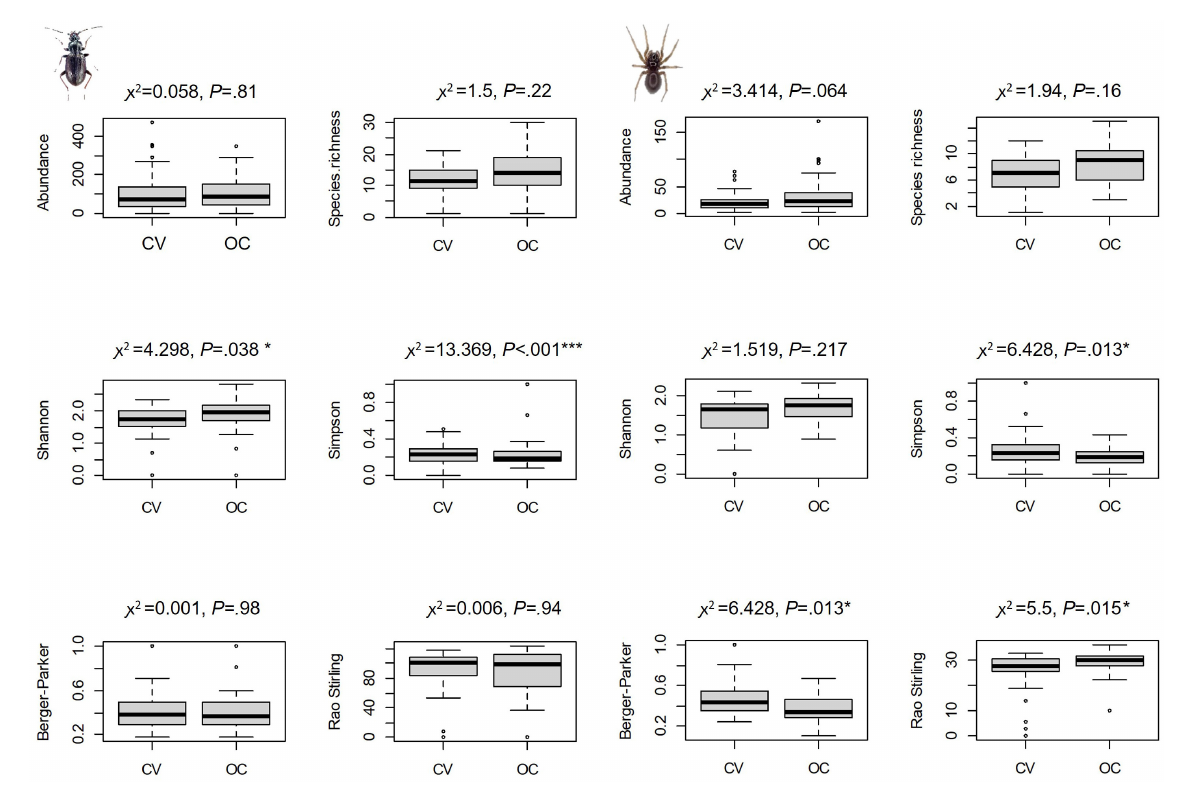
FIGURE2 Multiple boxplots for six diversity indices: abundance, species richness, Shannon, Simpson, Berger-Parker and Rao-Stirling indices for carabids and spiders in conventional (CV) and organic-conservation (OC) parcels. Results of χ 2 tests carried out on the mixed linear models ( χ 2 and P -values) of testing each diversity indicator between system types are indicated on the top of each boxplot. Asterisks illustrate the power of the levels of significance of the statistical test: “*” ≤ 0.05; “**” ≤ 0.01; “***” ≤